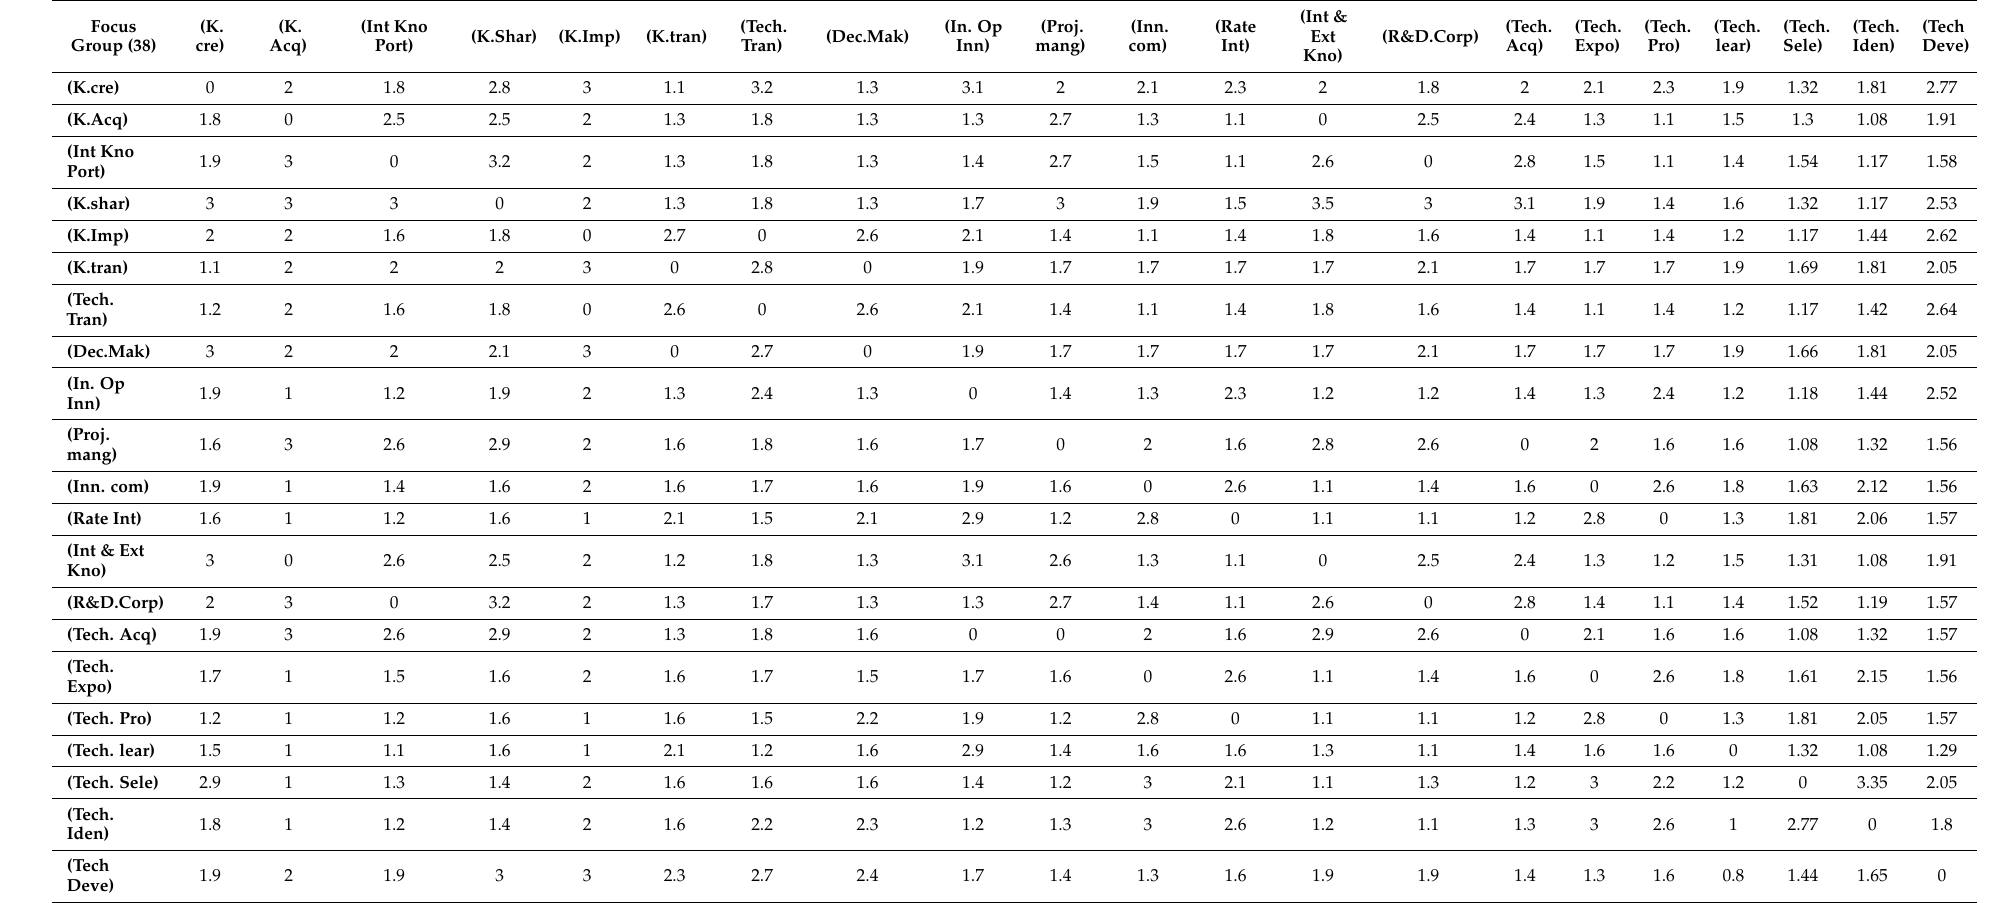
Table 4. The total average matrix T (Criteria) across 38